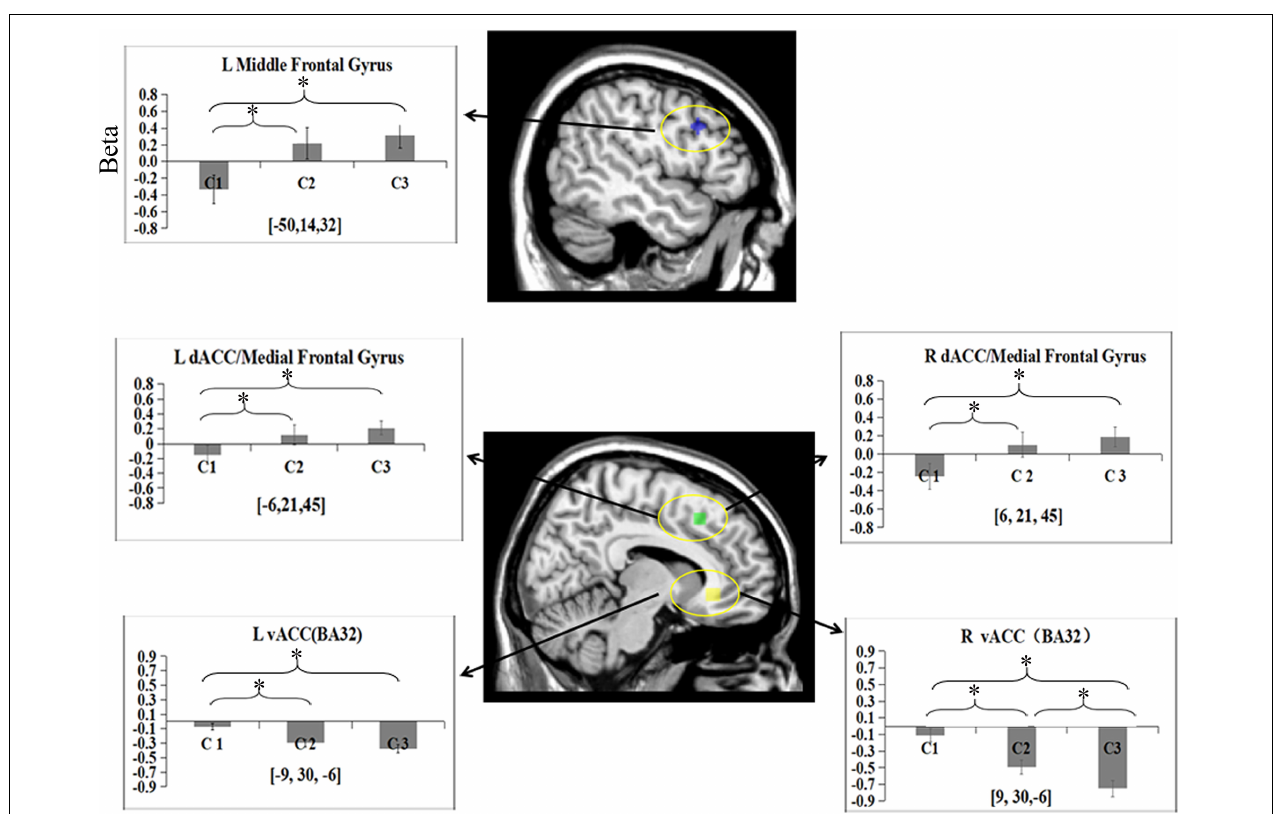
FIGURE 3 | Beta means within five ROIs for categorization phase among three conditions. Error bars represent SE of the mean across all participants. L, left; R, right. * p <